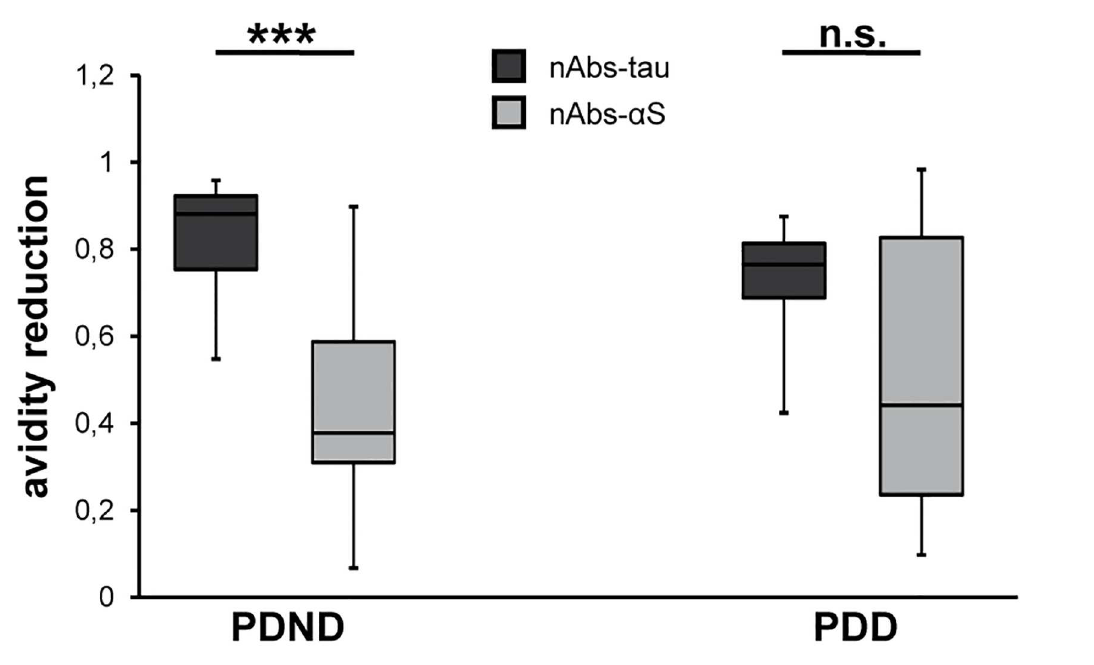
Fig 3. Distribution of the urea-mediated avidity reduction. For each non-demented (PDND) and demented Parkinson’s disease (PDD) patient, nAbs-tau and nAbs- α S avidity reduction was calculated. Box plots show the median, 25% and 75% quartile. 50% of the generateddata are located in the box and whiskers represent the minimum and maximum value. Significantdifferences were found within (PDND: *** p < 0.001; PDD: p = 0.057) but not between (PDND and PDD: p > 0.05) the patient